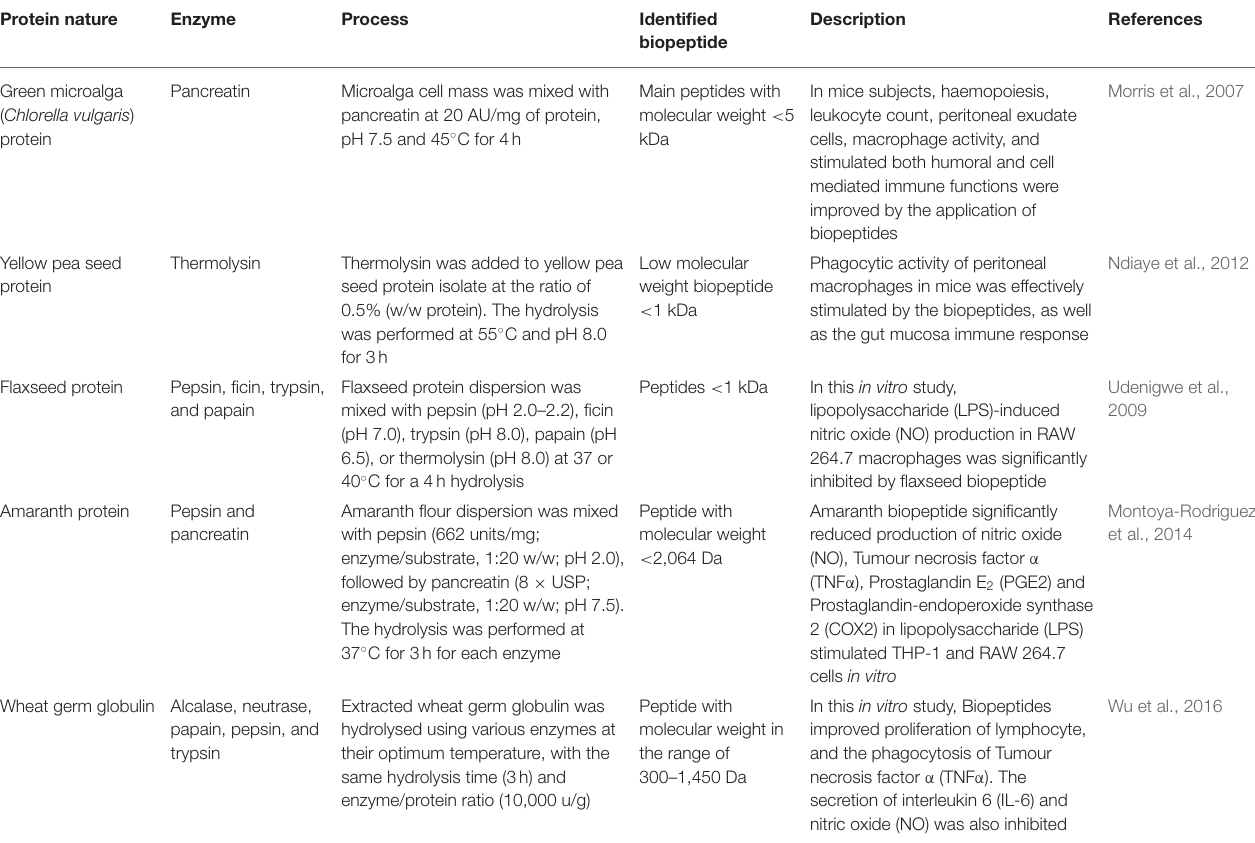
TABLE 4 | Examples of plant-based biopeptides with immunomodulatory activity. Protein